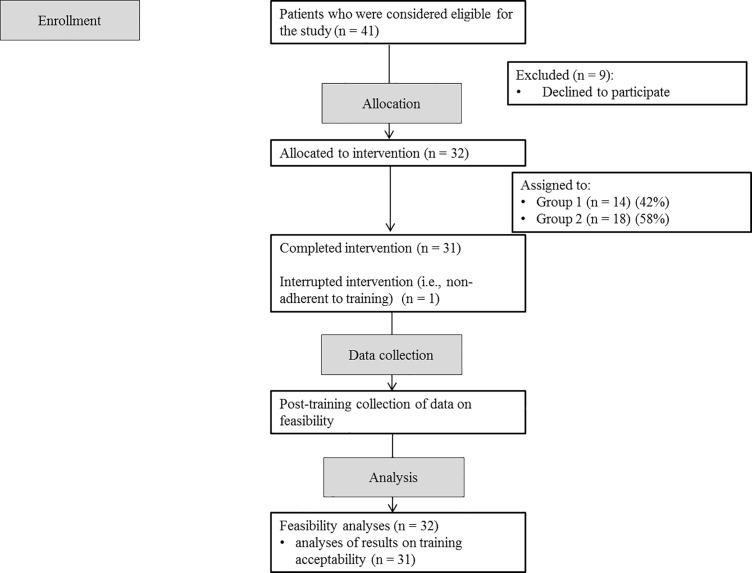
CONSORT flowchart of participant enrollment, inclusion, and involvement.